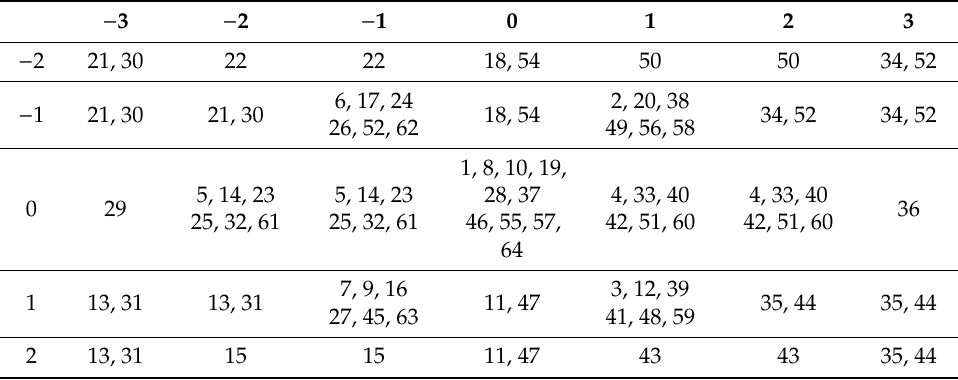
Figure 7. Diagram of the voltage vector modulator implementation. Table 4. Tables for the choice of the vector function of the sliding surfaces.